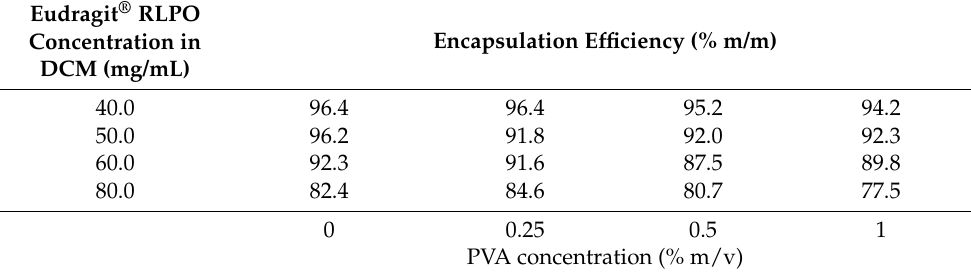
Figure 1. Influence of PVA (%) and Eudragit ® concentration (mg · ml − 1 ) on particle diameter (nm, ( left )) and process yield (%, ( right )). A change in color depth indicates a change in the respective parameter, as outlined in the legend. Table 1. Encapsulation efficiency of valsartan-loaded nanoparticles as a function of polymer and emulsifier